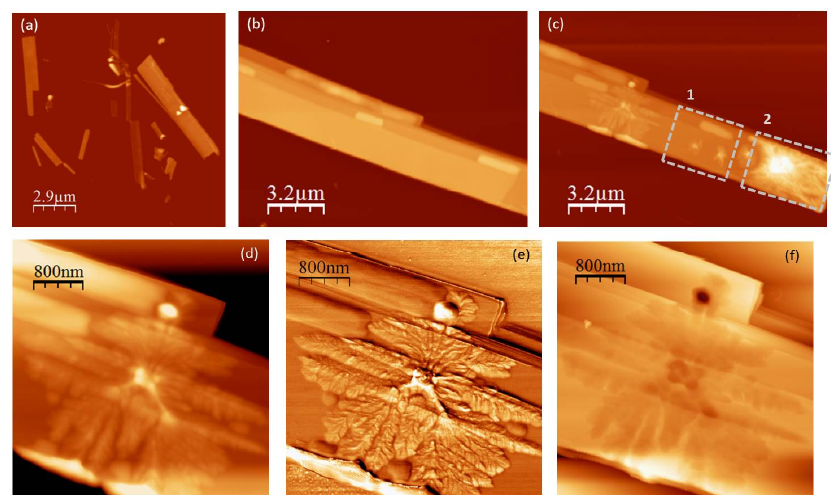
Figure 8. Oxidation in 3R-NbS 2 . ( a ) Topography image of various needle-like stacks of 3R-NbS 2 onto a Si substrate; ( b ) Topography image of a needle of 3R-NbS 2 previous to its oxidization; and ( c ) same needle oxidized in distinct places employing different oxidation parameters. Two areas are highlighted in dashed squares, (1) oxide dendritic growths oxidized at − 30 V and 50 ms and (2) oxide formation produced at − 35 V and 100 ms; ( d ) Topography image of a dendrite oxide formation onto a needle of 3R-NbS 2 produced at − 30 V and 100 ms; ( e ) phase image corresponding to ( d ); ( f ) Topography image of the etched oxide shown in figure ( a ).